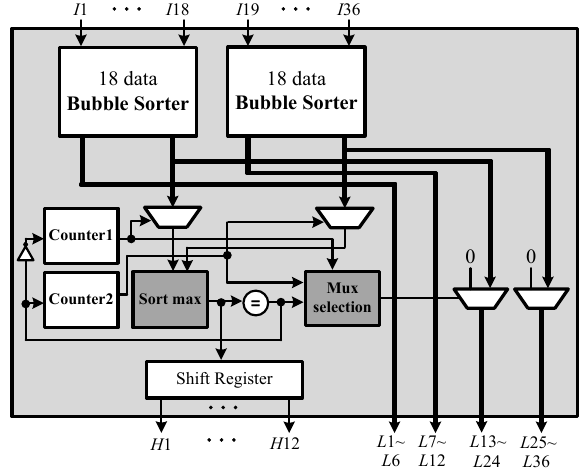
Figure 11. Hardware architecture of SU ( N = 36; p = 24).